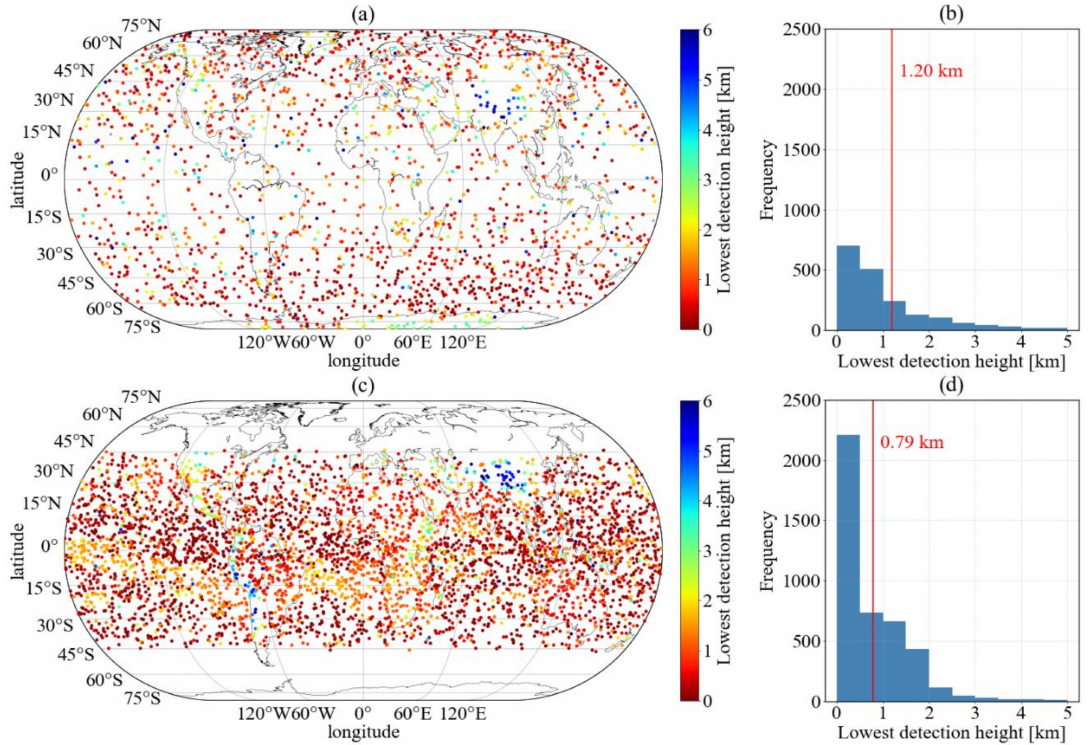
Figure 1. The location of RO profiles ( a ) for COSMIC on 15 October 2008 and ( c ) COSMIC-2 on 15 October 2020. ( b ) and ( d ) show the statistical histograms of the lowest detection height corresponding to ( a ) and ( c ), respectively. The red vertical line represents the mean of the lowest detection height.